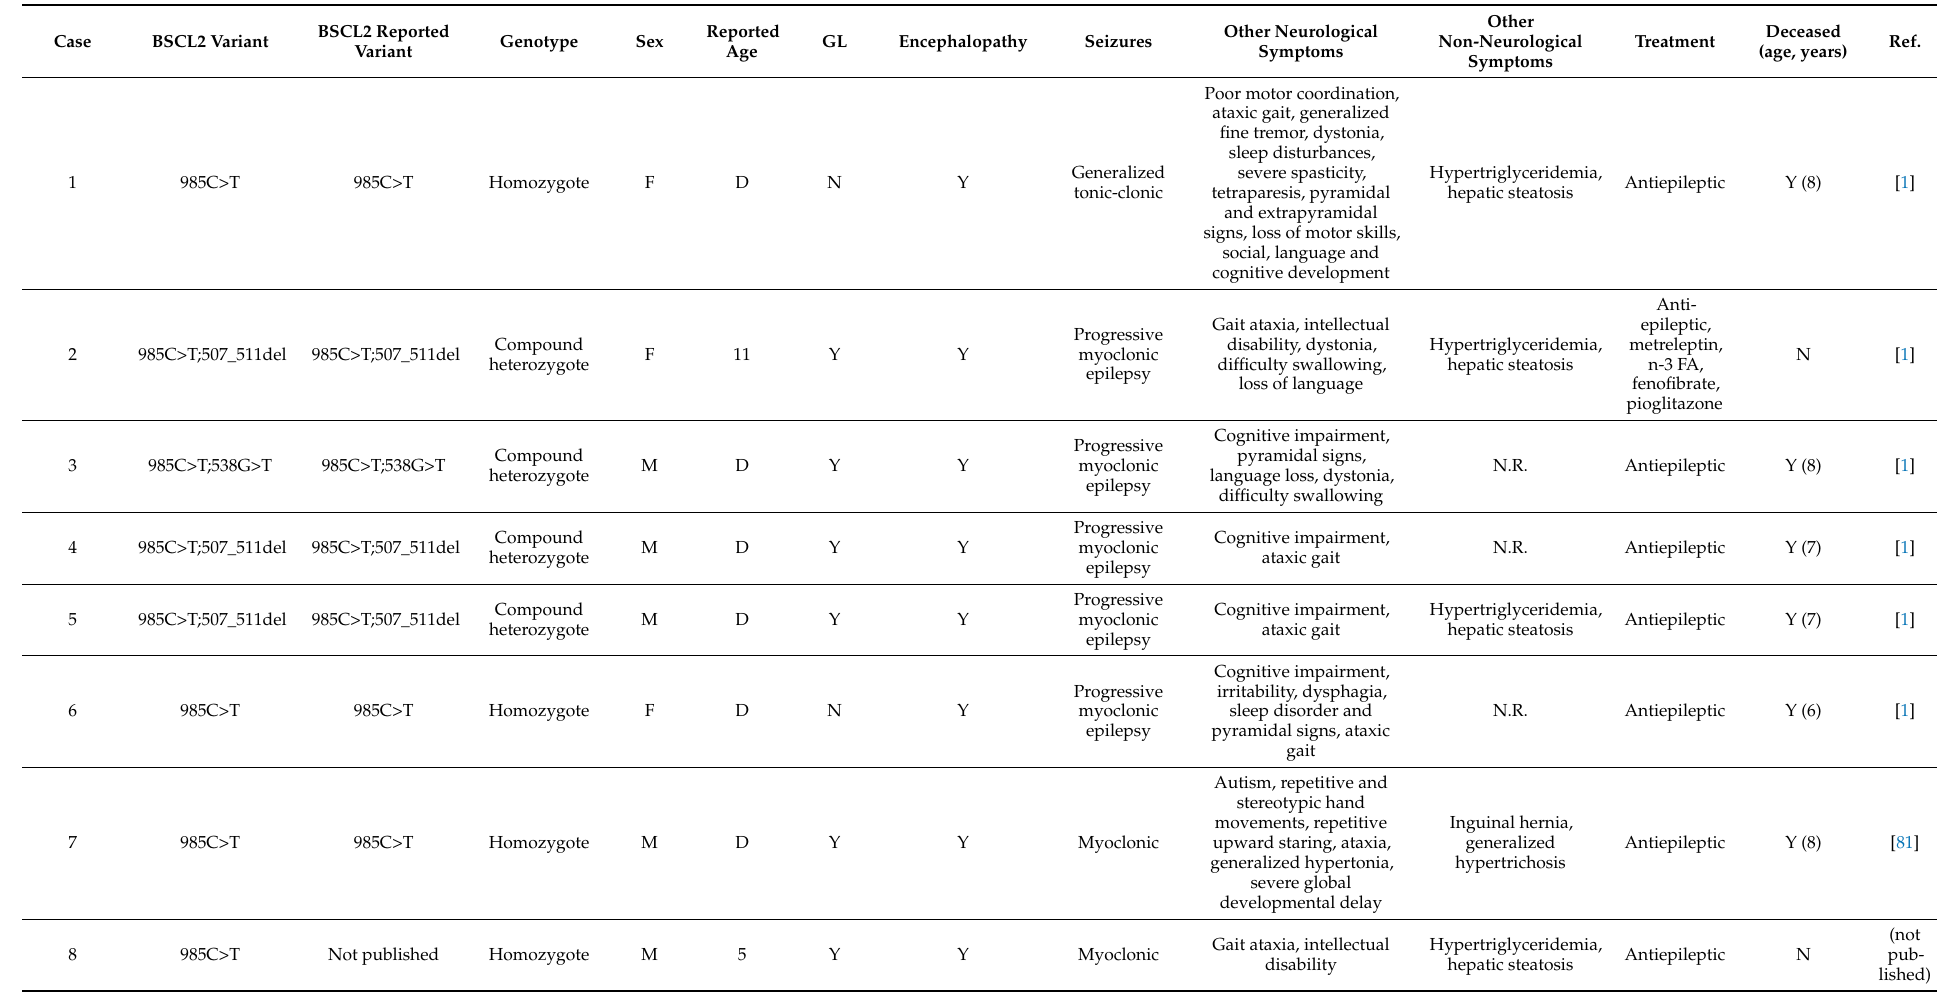
Table 1. Progressive encephalopathy with or without lipodystrophy (PELD) BSCL2 variants referred to transcript NM_001122955 3 geographical distribution of PELD cases is depicted in Figure